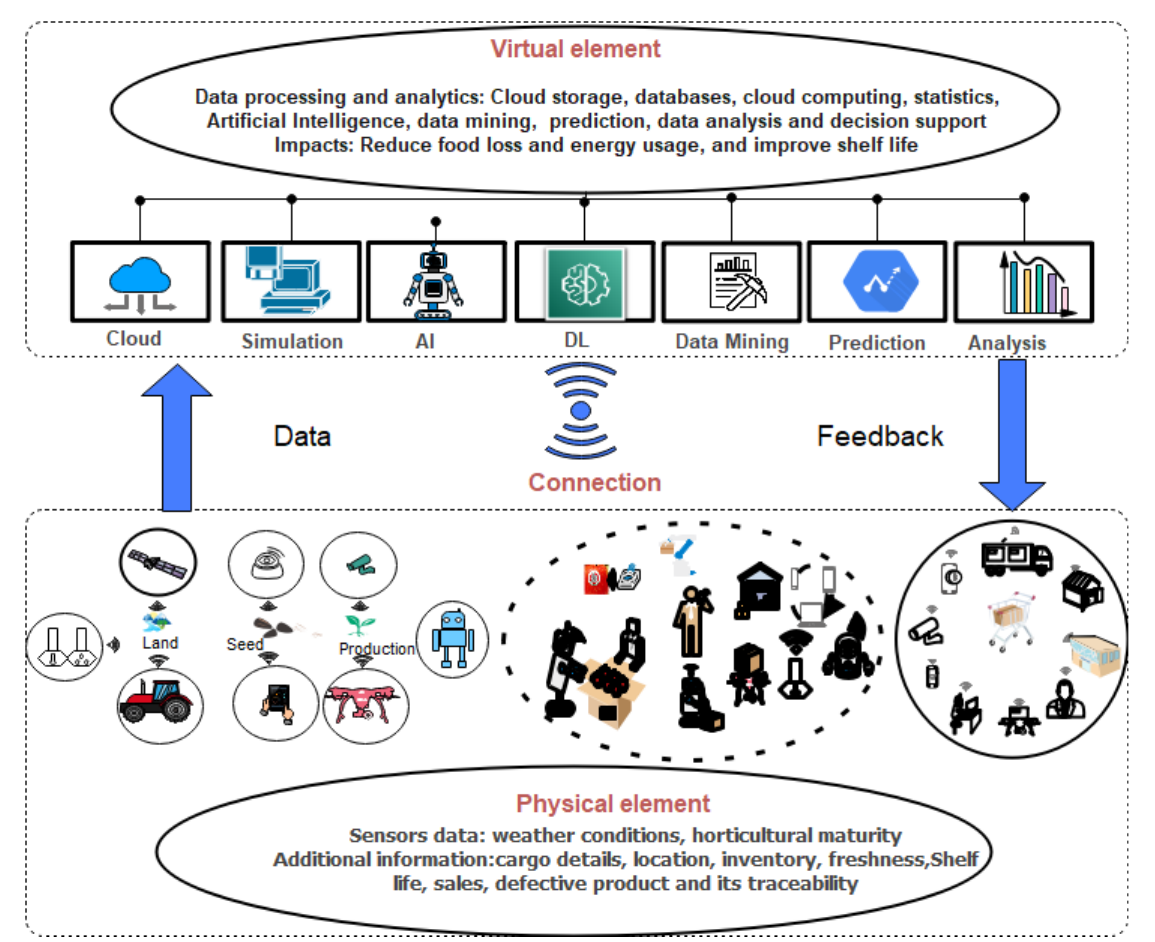
Figure 9. Digital twin for food supply chain.